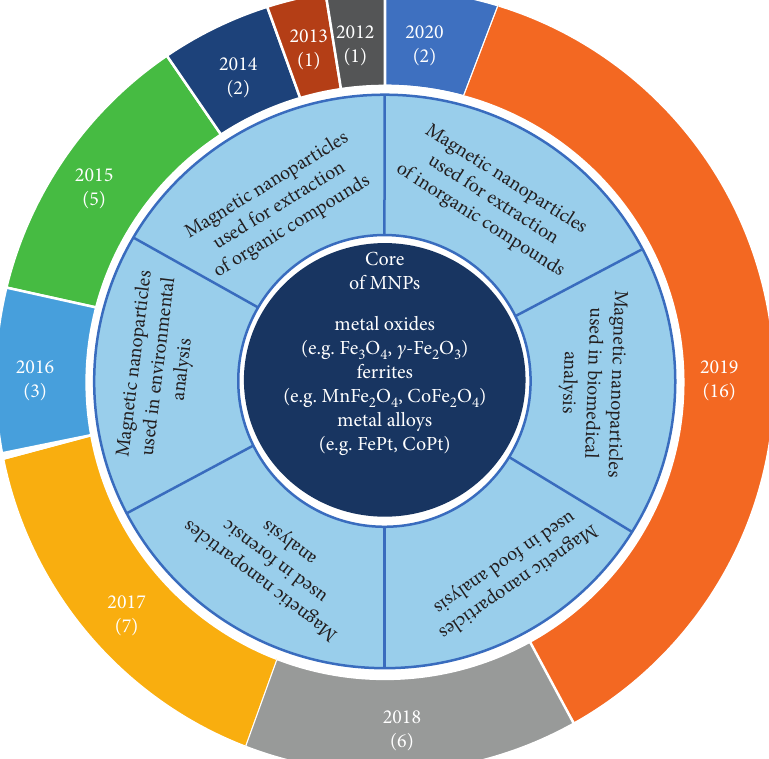
Figure 1: Overview of the applications of magnetic nanoparticles (MNPs) in scientific fields together with an illustration showing the number of reviews that had been annually published on this topic between January 2012 and April 2020 (according to the Web of Science database).